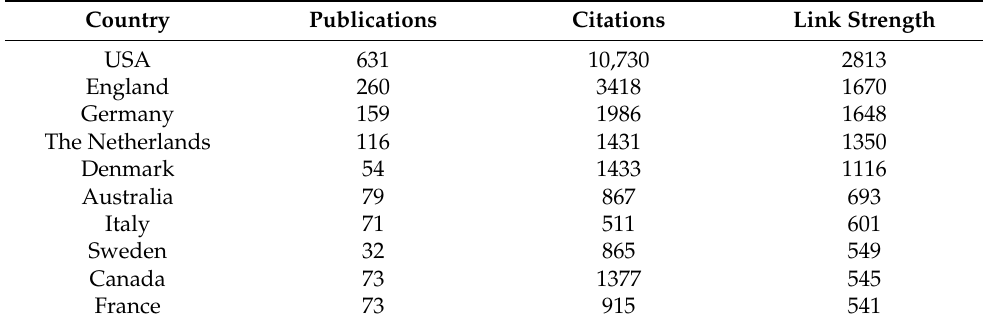
Table 4. Top 10 publication countries (n =